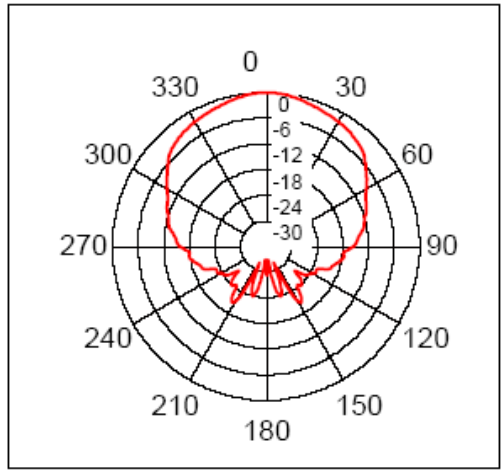
Figure 10 . 400ST120 Beam